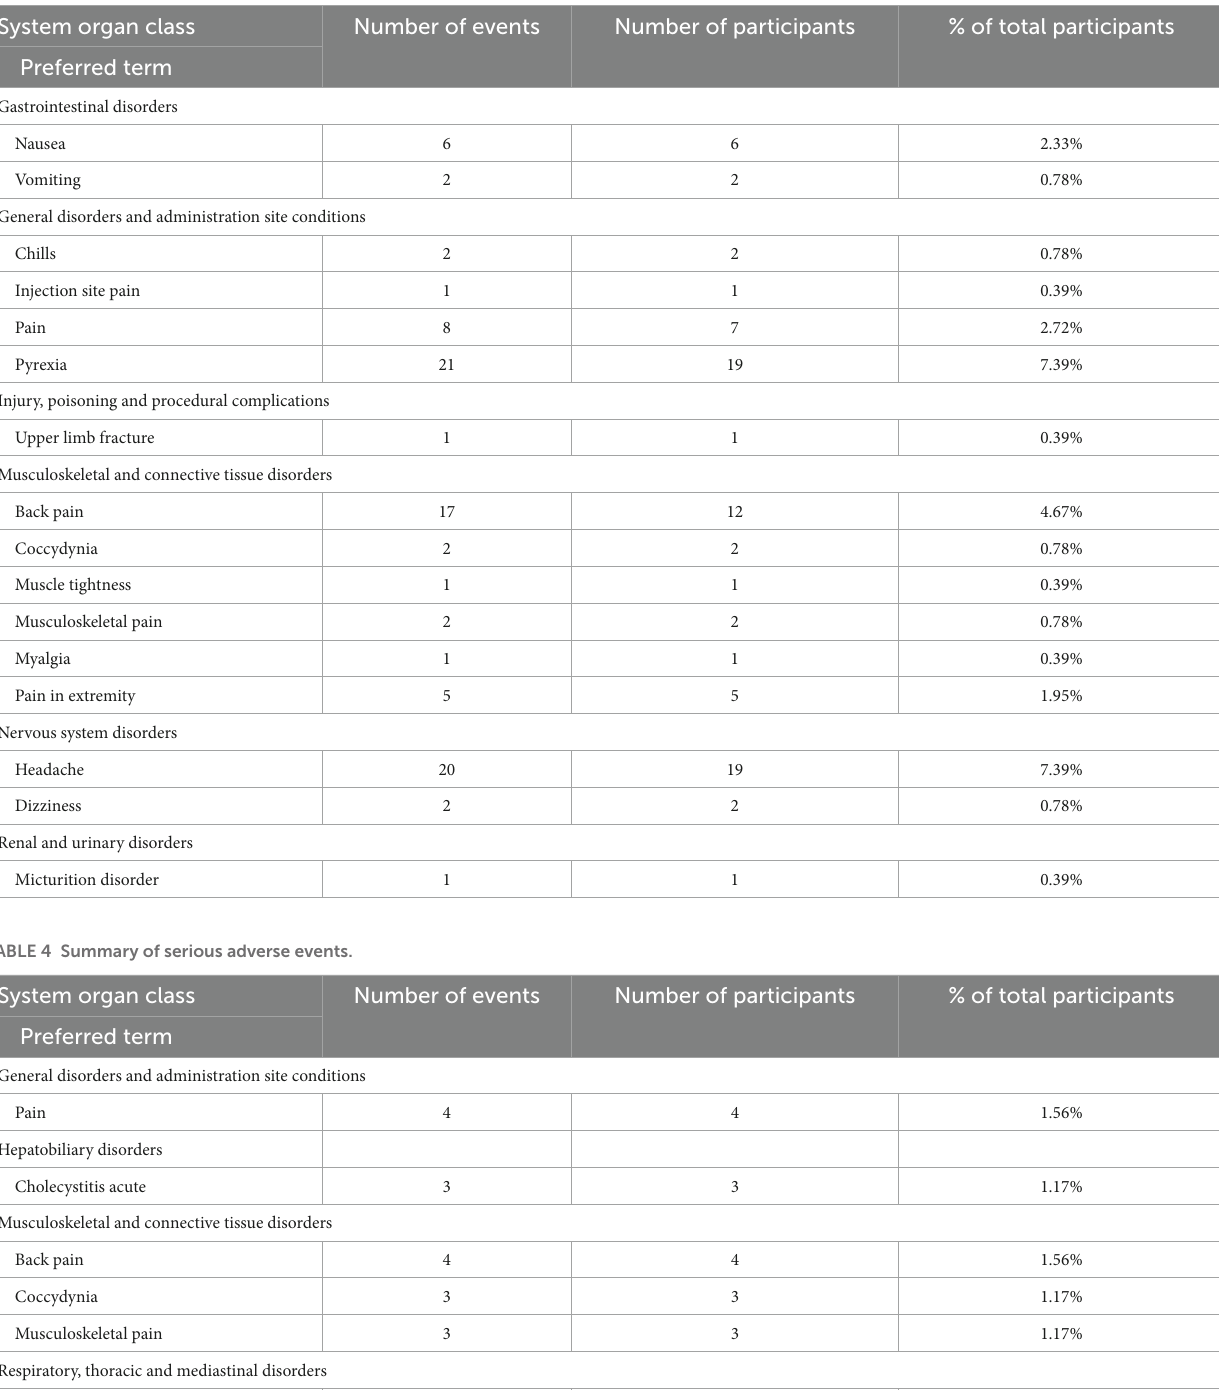
TABLE 3 Summary of adverse drug reactions.